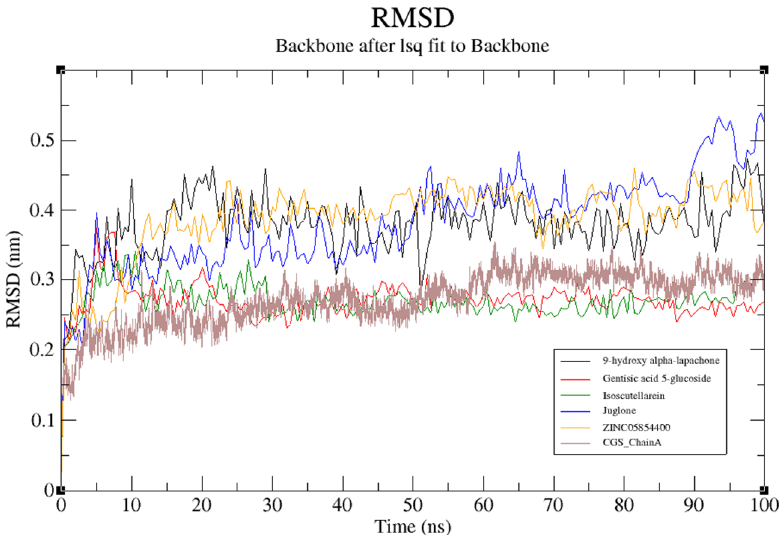
Figure 10. RMSD versus time plot of the backbone of CGS superimposed with CGS complexes. The molecular dynamics simulations were run for 100 ns.